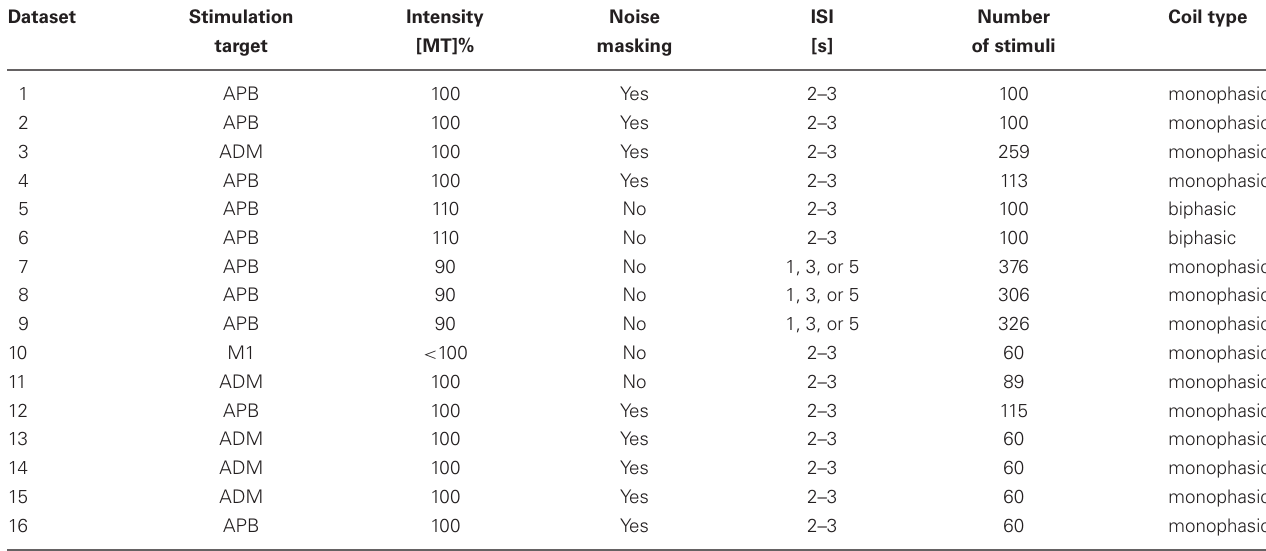
Table 1 | The measurement parameters in different datasets.